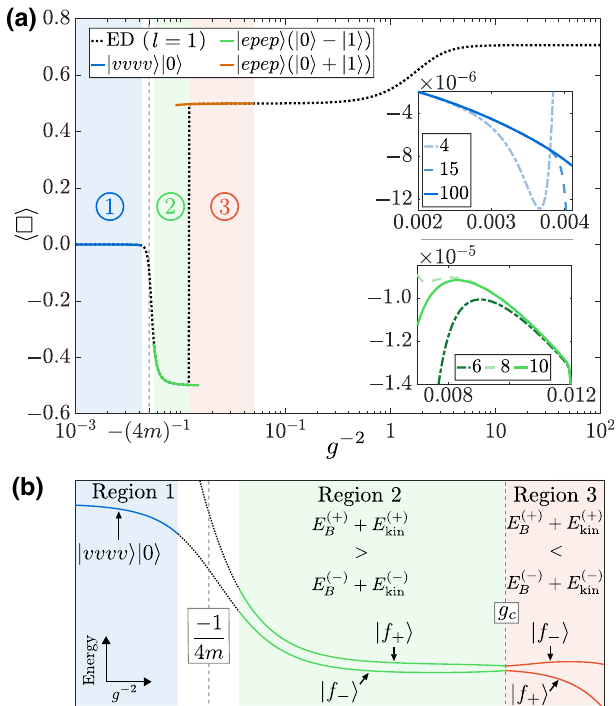
FIG. 8. (a) The plaquette expectation value as a function of g − 2 for a single plaquette with mass m = − 50 and kinetic strength (cid:4) = 5. Regions 1, 2, and 3 correspond to the num- bered regions in (b). Exact diagonalization of the truncated model is represented by the black dashed line and perturbation the- ory is used for the blue, green, and orange lines. The insets are magnifications of parts of regions 1 and 2 (blue and